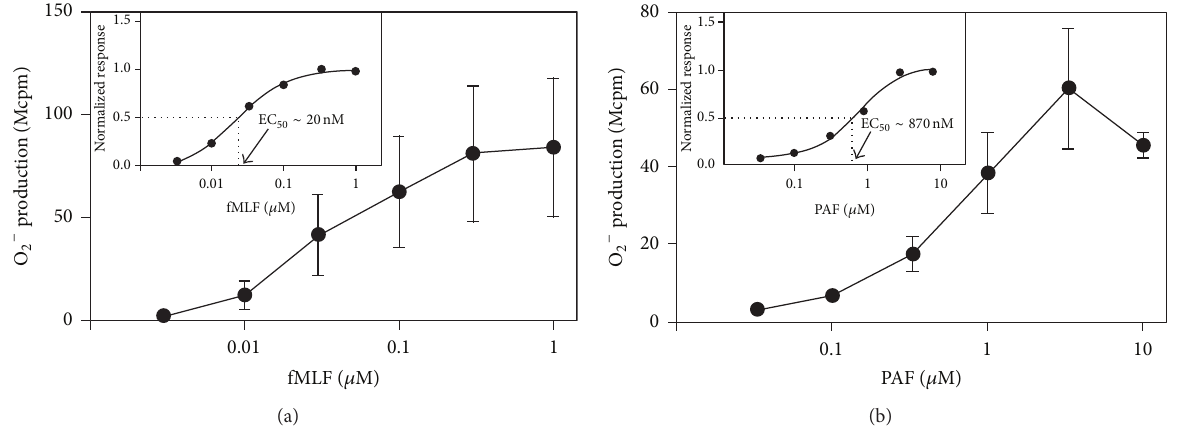
Figure 3: PAF and fMLF dose dependently trigger the release of superoxide anions from human neutrophils. Human neutrophils (10 5 cells) were incubated at 37 ∘ C for 5 min in measuring vials containing isoluminol and HRP. Various concentrations of fMLF (A) or PAF (B) were added, and the release of superoxide anions was recorded continuously. Data are expressed as mean peak value ± SEM ( 𝑛 = 5 ). Abscissa, agonist concentration; ordinate, superoxide production expressed as counts per minute × 10 6 (Mcpm). The insets show one representative normalized dose-response experiment with respective EC 50 values calculated for fMLF (A) and PAF (B),